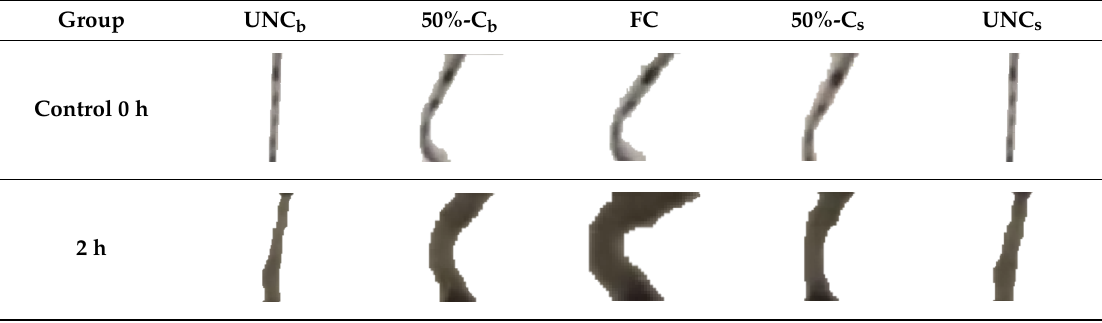
Table 1. Bending/straightening behavior of samples with and without 2 hours (2 h) of elastin degradation. Group UNC b